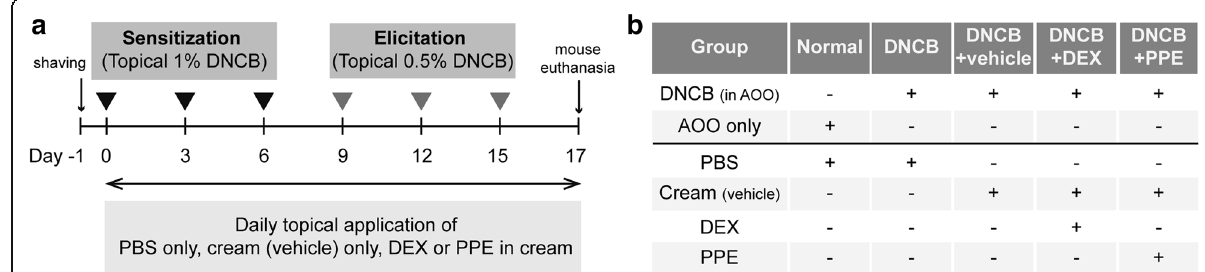
those administered cream alone or PBS as the negative control (Fig. 1b).